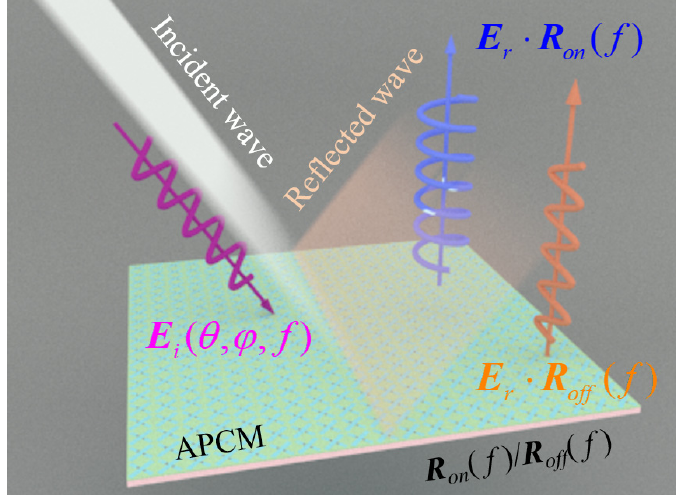
Figure 1. The basic principle of the APCM.